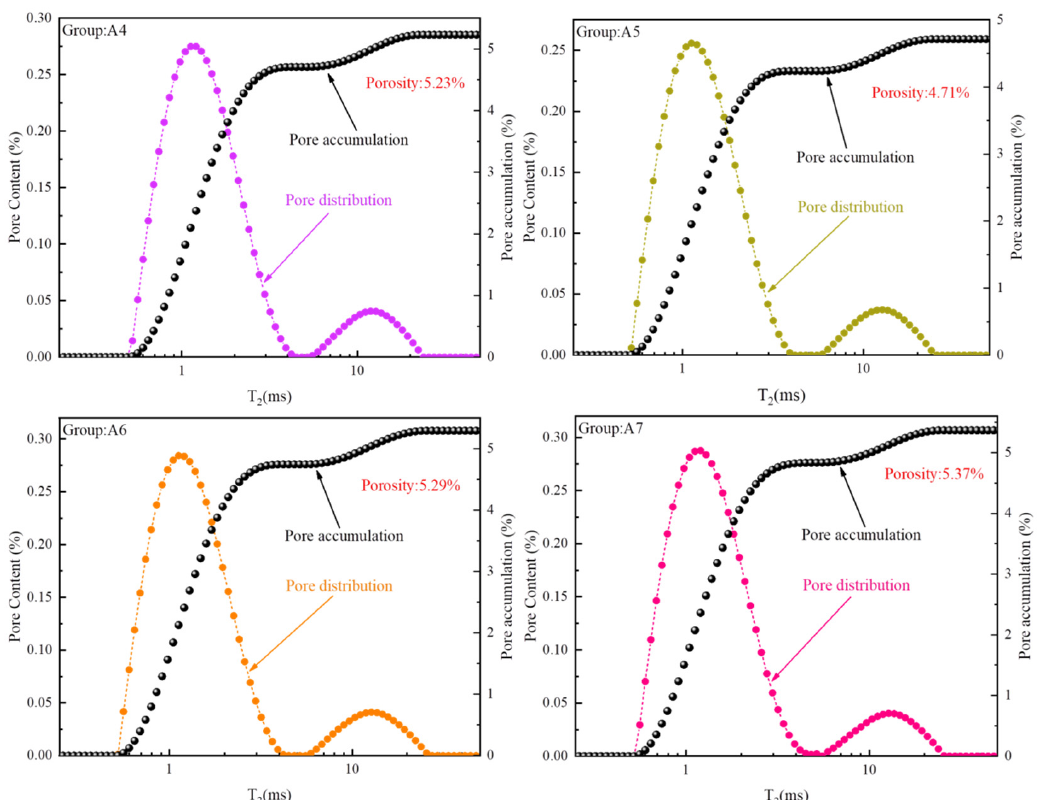
Figure 4. Pore distribution of each group LMPGCB.